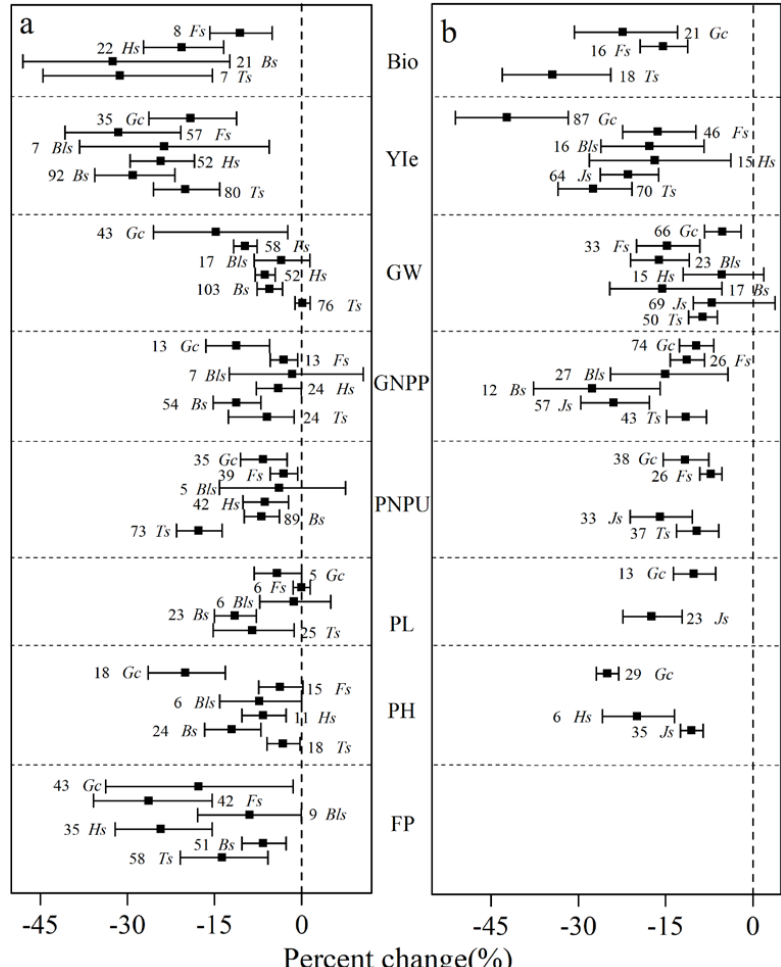
Figure 4. Response of rice and wheat to drought at different growth stages. Numbers near the symbols specify the number of data points and the error bars indicate a 95% confidence interval.